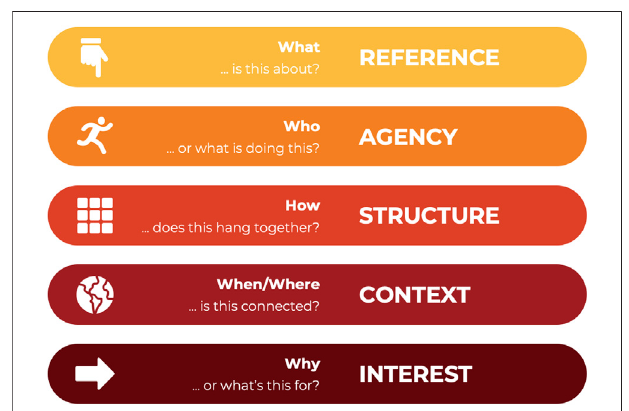
FIGURE 3 | The functions of meaning of transpositional grammar (Cope and Kalantzis in